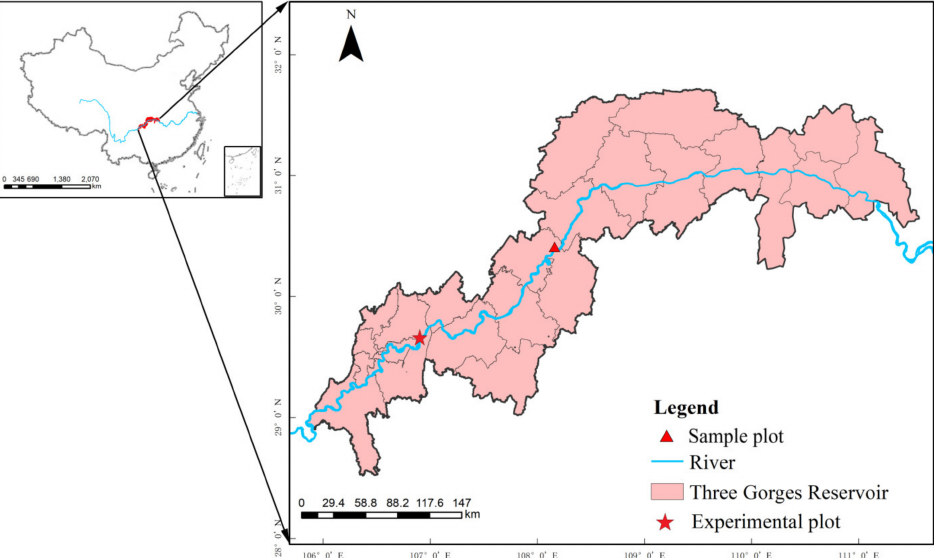
Figure 1. Locations of sample and experiment site in the riparian zone of the Three Gorges Dam,